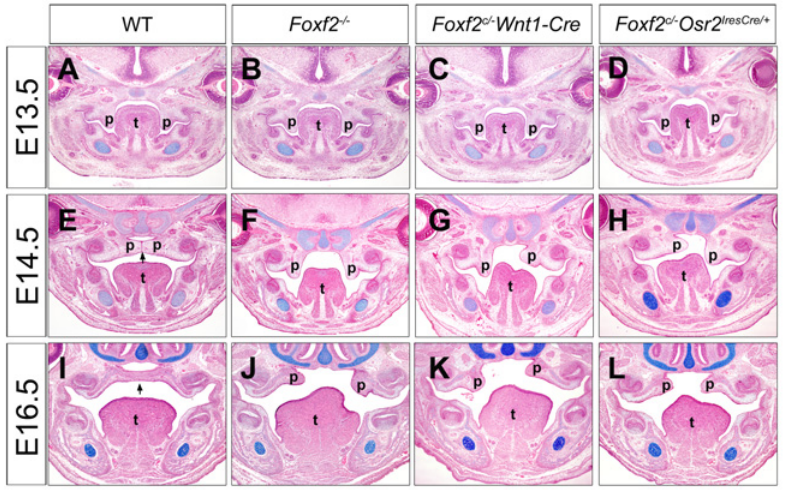
Fig 1. Histological analysis of palate developmental defects in Foxf2 mutant mouse embryos. Representative frontal sections of wildtype (A, E, I), Foxf2 -/- (B, F, J), Foxf2 c/- Wnt1-Cre (C, G, K), and Foxf2 c/- Osr2 IresCre/+ (D, H, L) embryos at E13.5 (A-D), E14.5 (E-H) and E16.5 (I-L). p, palatal shelf; t,